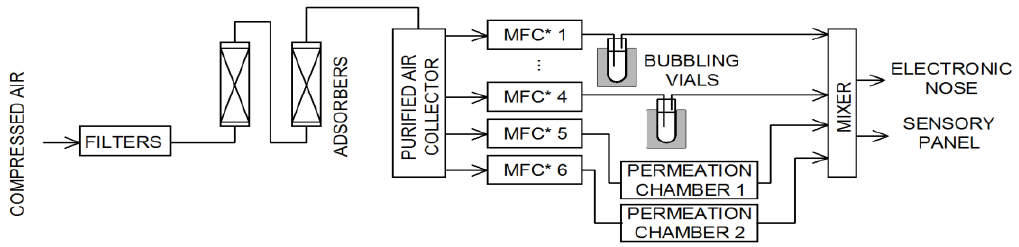
Figure 1. Gas mixture generator schematic (MFC — mass flow controllers).